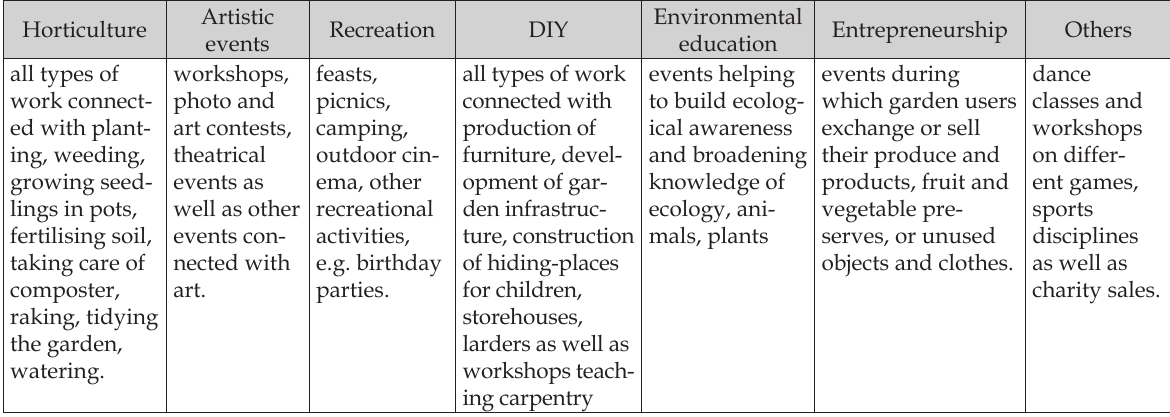
Table 2. Types of events organised in community gardens.